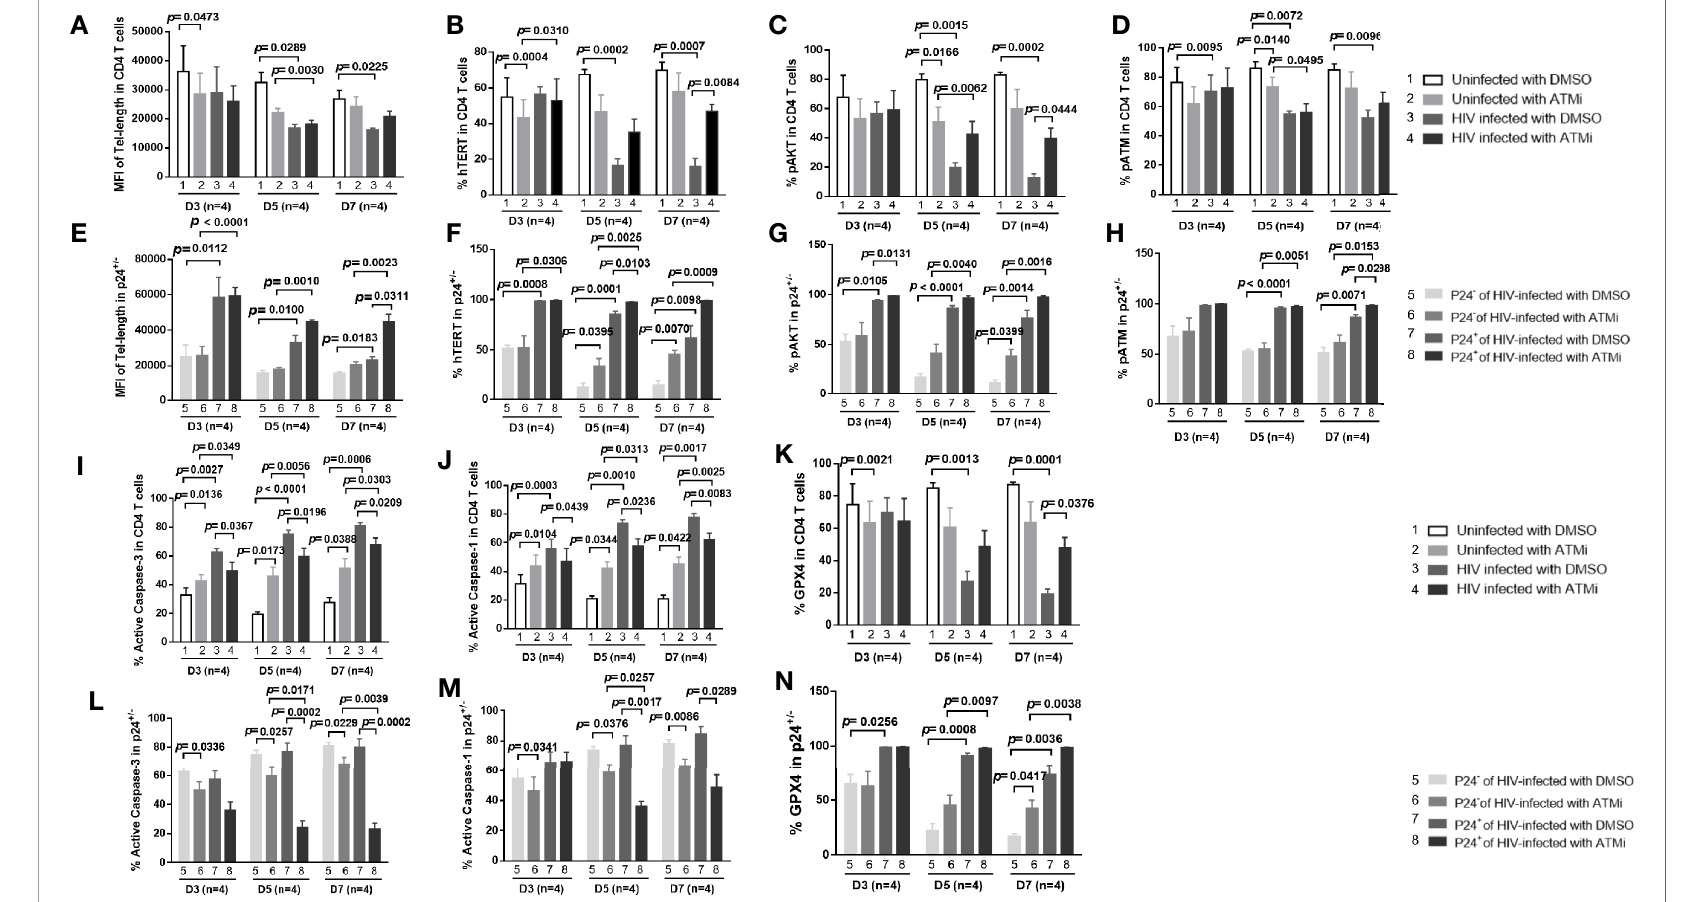
FIGURE 6 | ATM blockade promotes HIV-infected cell survival via rescuing AKT and telomerase activities by inhibiting HIV infection and DNA damage response (DDR). (A – D) HIV-infected and uninfected CD4 T cells were treated with DMSO control or ATM inhibitor for 3, 5, and 7 days, followed by measuring telomere length, hTERT, pAKT, and pATM by fl ow cytometry. (E – H) Summary data of the MFI of telomere length, the % of hTERT, pAKT, and pATM expressions in p24 + and p24 - cells following HIV infection with ATMi or DMSO treatment for 3, 5, and 7 days. (I – K) Summary data of the % of active caspase-3, active caspase-1, and GPX4 expressions in HIV-infected and uninfected CD4 T cells treated with DMSO or ATMi for 3, 5, and 7 days. (L – N) Summary data of the % of active caspase-3, active caspase-1, and GPX4 expressions in p24 + and p24 - cells following HIV infection with ATMi or DMSO treatment for 3, 5, and 7